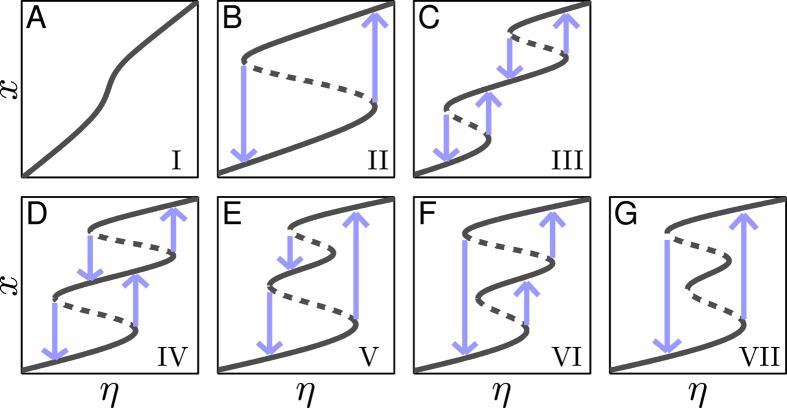
Schematic description of seven types of bifurcation diagrams for both the PP and PN circuits.Types I and II and type I are allowable for individual PFLs and NFLs, respectively. The solid and dashed lines denote stable and unstable steady states, respectively. The blue lines indicate possible transitions between steady states via SN bifurcation. Both axes are in log scale.